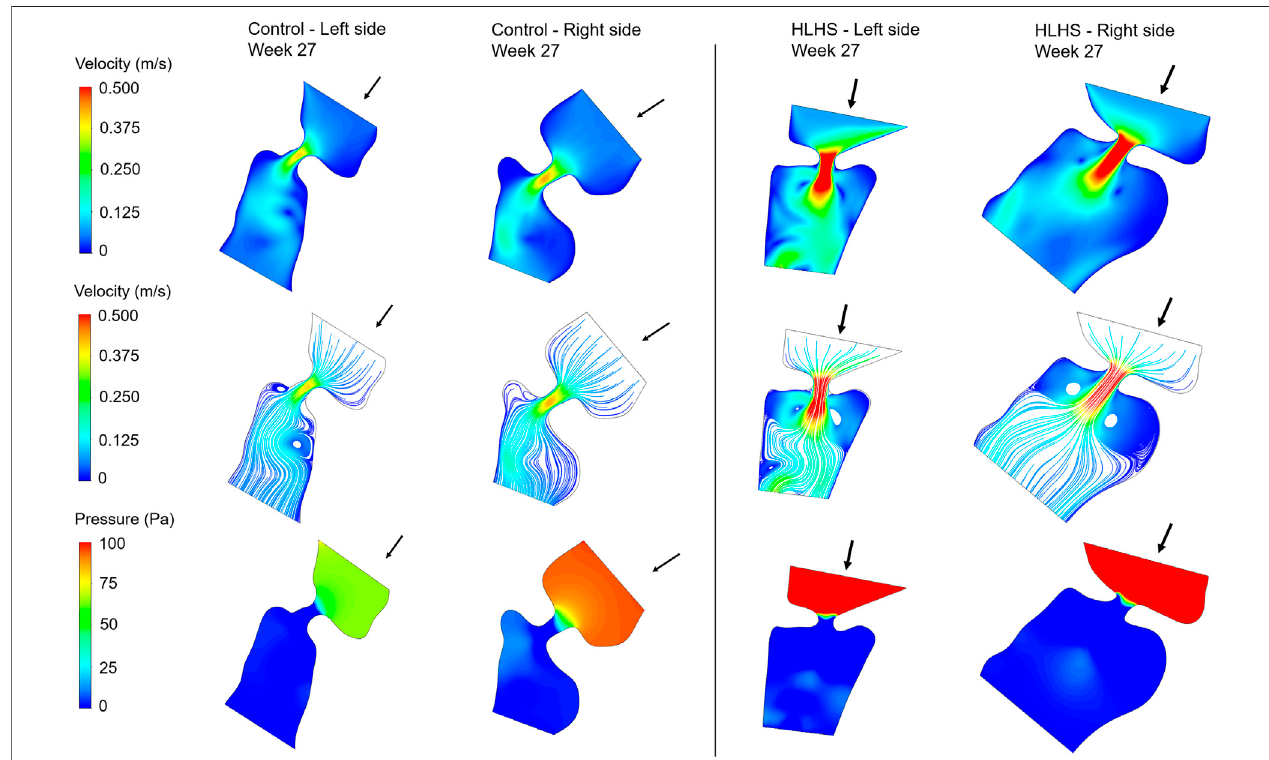
FIGURE 8 | Velocity contours, fl ow streamlines, and pressure contours at the instant of peak inlet fl ow rate for 27-week control and HLHS hearts. The arrows indicate the fl ow direction at the inlet.